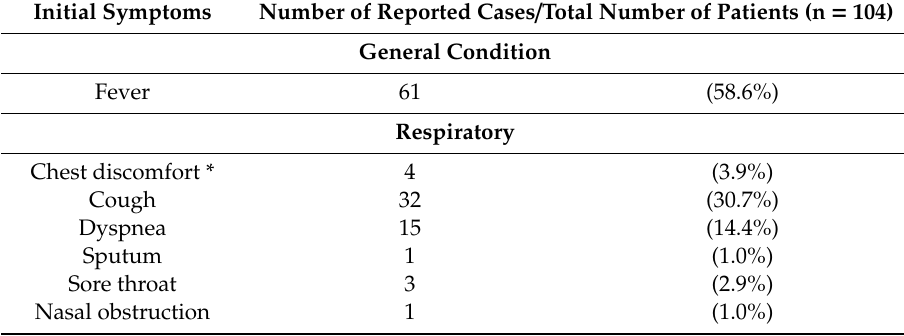
Table 3. Initial symptoms of pregnant patients with COVID-19.